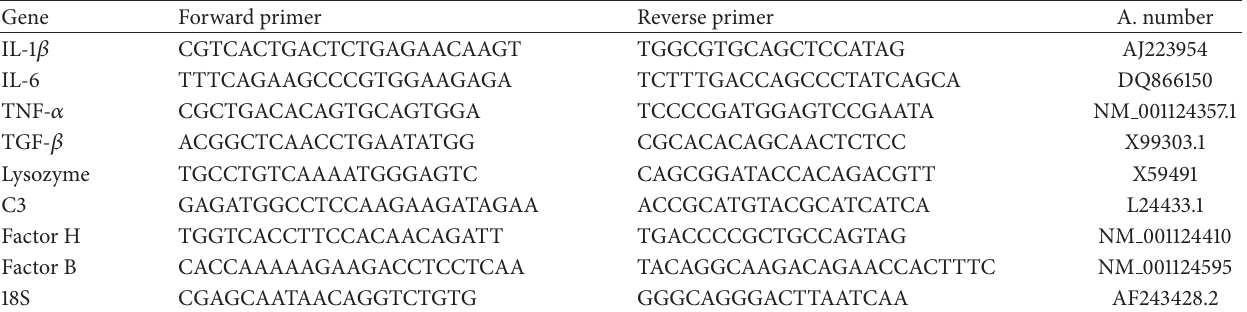
Table 1: Sequences of primers used in gene expression analysis and accession